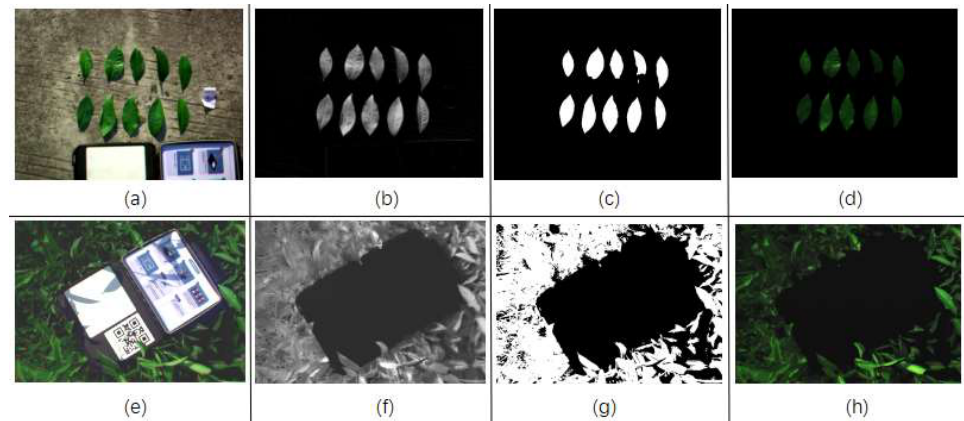
Figure 6. Images corresponding to the different steps of the background removal process. ( a ) Original multispectral image pre-processed at leaf scale; ( b ) multispectral image enhanced with the full channel difference vegetation index; ( c ) image after binarisation with Otsu; ( d ) image with binarisation of the multispectral image after masking the original multispectral image; and ( e – h ) canopy-scale spectral images processed in the same order as ( a – d ), respectively.